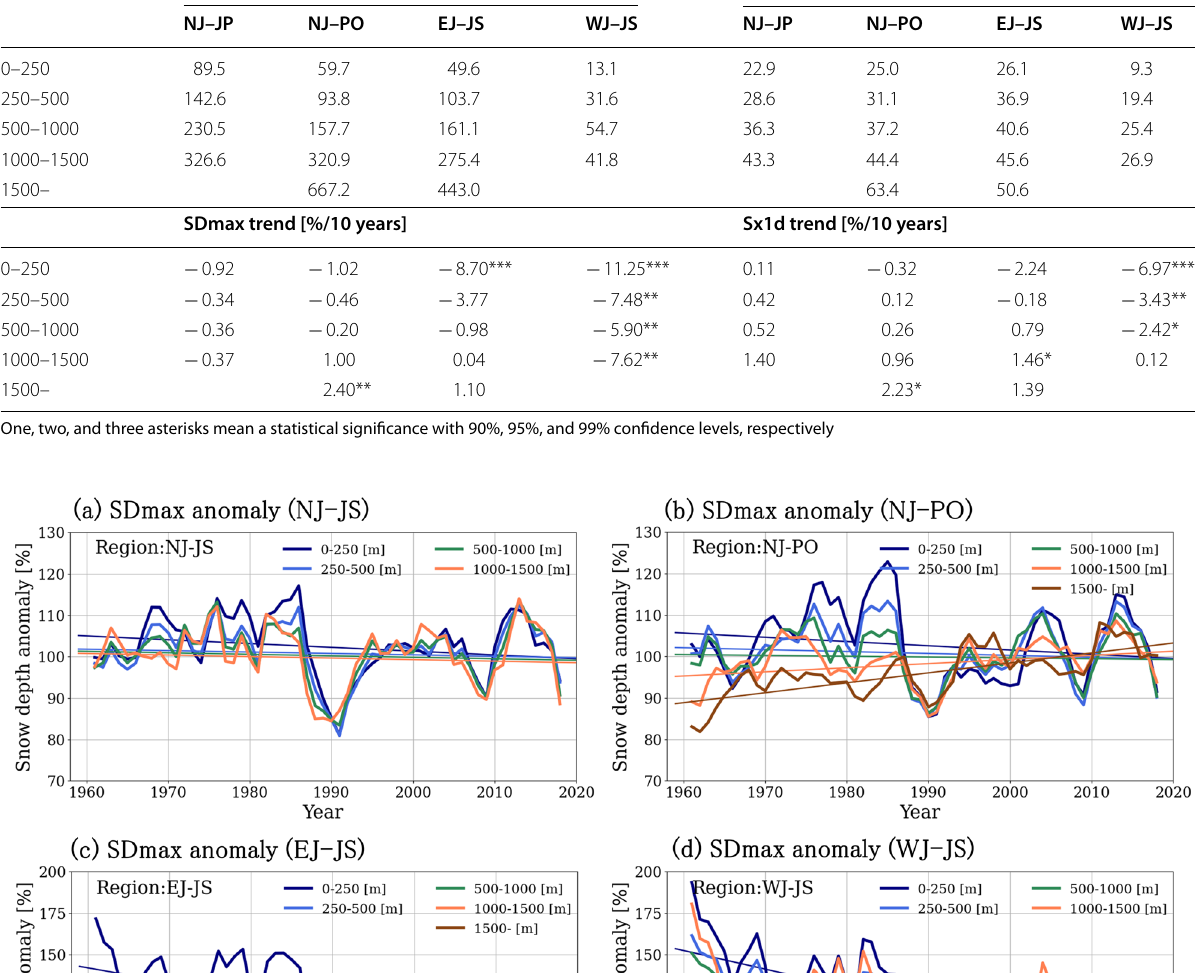
Table 2 SDmax and Sx1d climatology and linear trends Elevation(m)